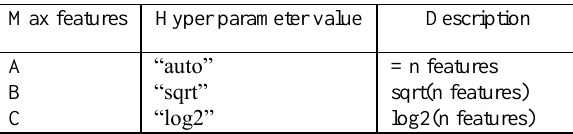
Table 2. Hyper parameter values for max_features. Source: sklearn RandomForestRegressor module version 0.19.1 (Pedregosa et al., 2011)